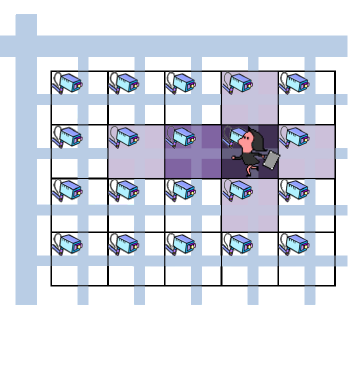
Figure 3 . Camera sensor